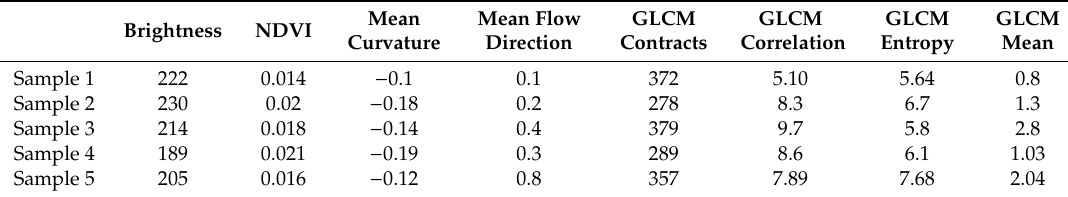
Table 1. The resulting threshold values for five samples of known